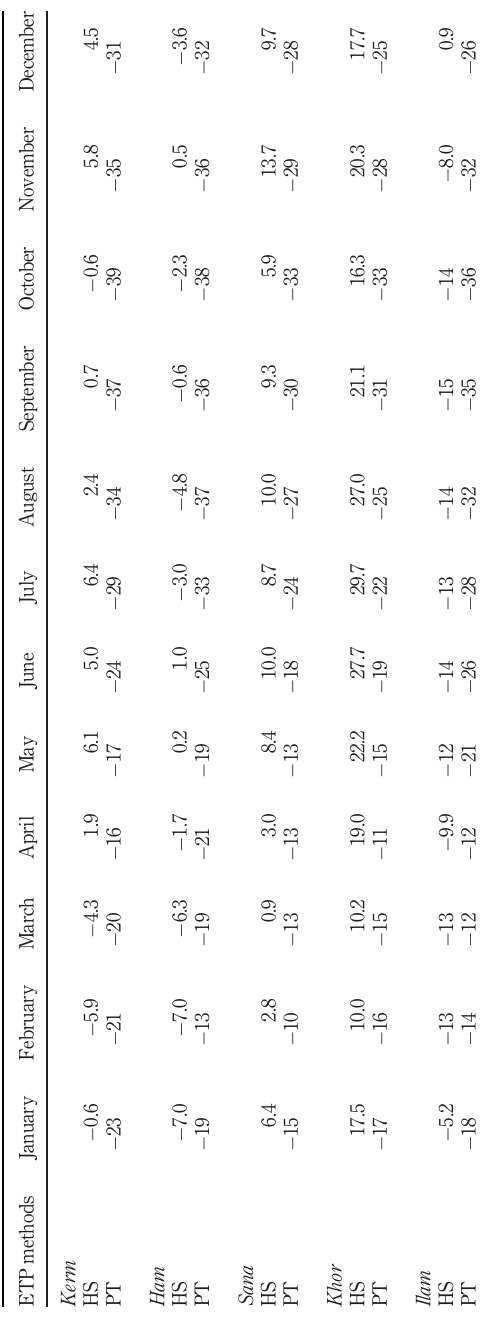
Table III. ETP Difference percentage by H-S and P-T methods with P-M method in the observed